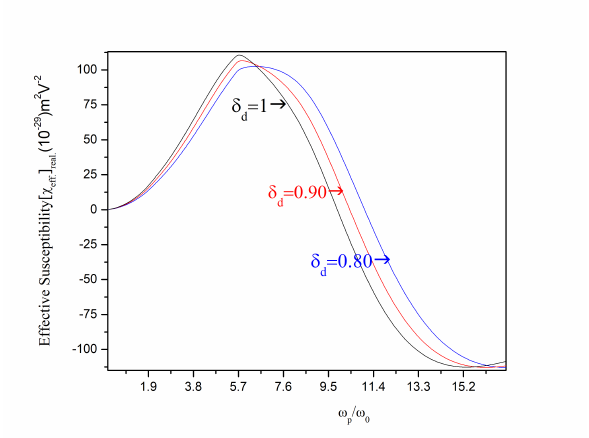
(cid:2) (cid:3) with carrier concentration [ in terms of ω p / ω 0 ] when E 0 = 5 × 10 7 Vm − 1 . χ ef f . real